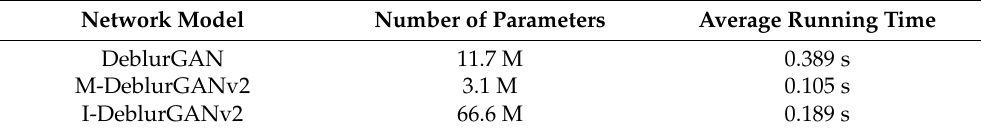
Table 2. Efficiency of the three